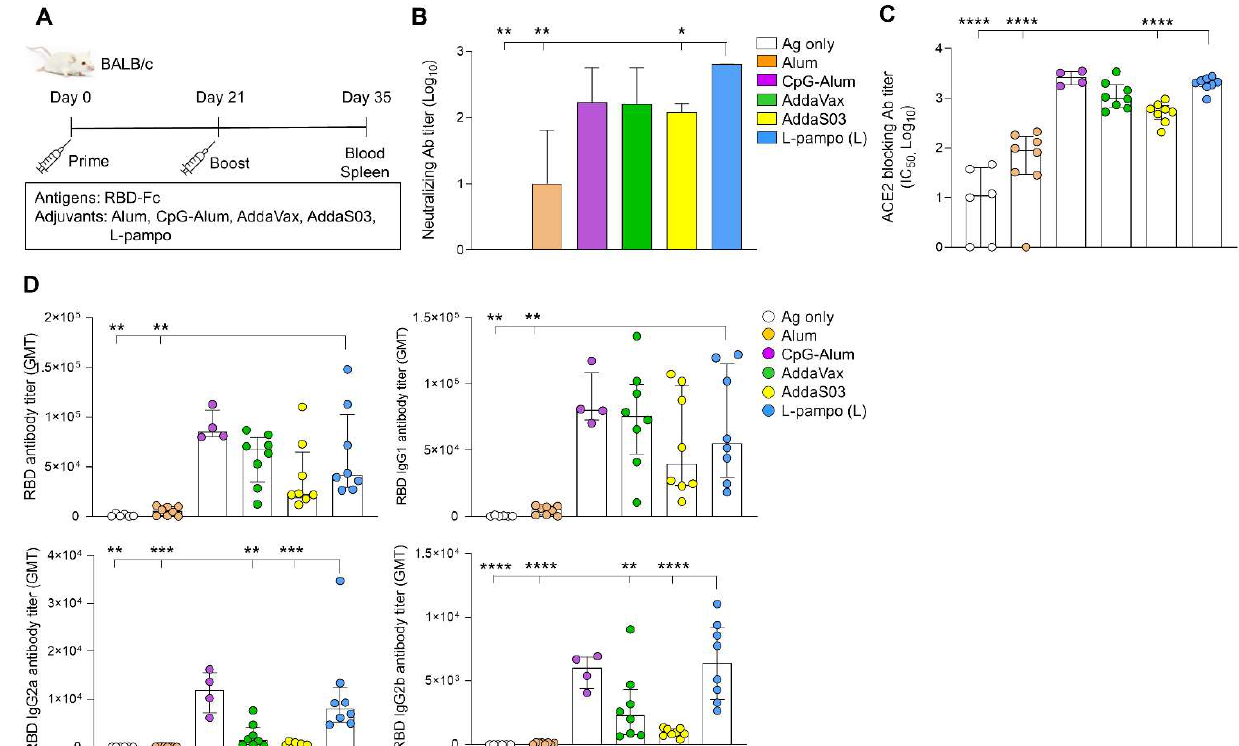
Figure 3. RBD-Fc antigen with L-pampo induces robust humoral responses. ( A ) A schematic of the immunization strategy. BALB/c mice (total n = 42; n = 6/antigen-only; n = 8/Alum, AddaVax, AddaS03, or L-pampo (L); n = 4/CpG–Alum) were immunized with RBD-Fc with or without adjuvants i.m. on day 0 and day 21. ( B ) Neutralizing antibody production on day 35. ( C ) ACE2-blocking antibody titers on day 35. ( D ) Total RBD-specific IgG, IgG1, IgG2a, and IgG2b antibodies on day 35. Data shown are median ± IQR. Each dot represents an individual mouse. GMT in the antibody assay indicates geometric mean titers. Data reflect 2 independent experiments (n = 3/antigen-only group; n = 4/Alum, AddaVax, AddaS03, or L-pampo (L) group; n = 2/CpG-Alum group in single experiment). Asterisks indicate statistically significant differences in comparison to the L-pampo (L) group. * p < 0.05; ** p < 0.01; *** p < 0.001; **** p < 0.0001; one way ANOVA with the Tukey’s test.